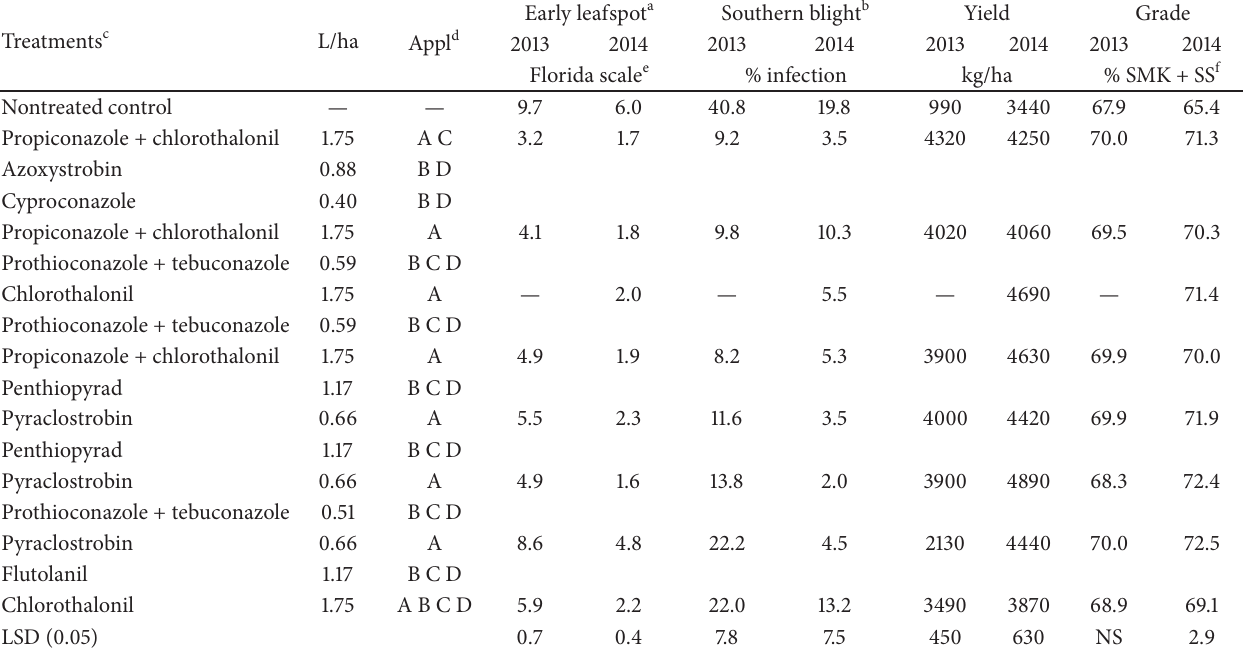
Table 2: Control of peanut diseases, yield, and grade when using foliar fungicides in South Texas. Treatments